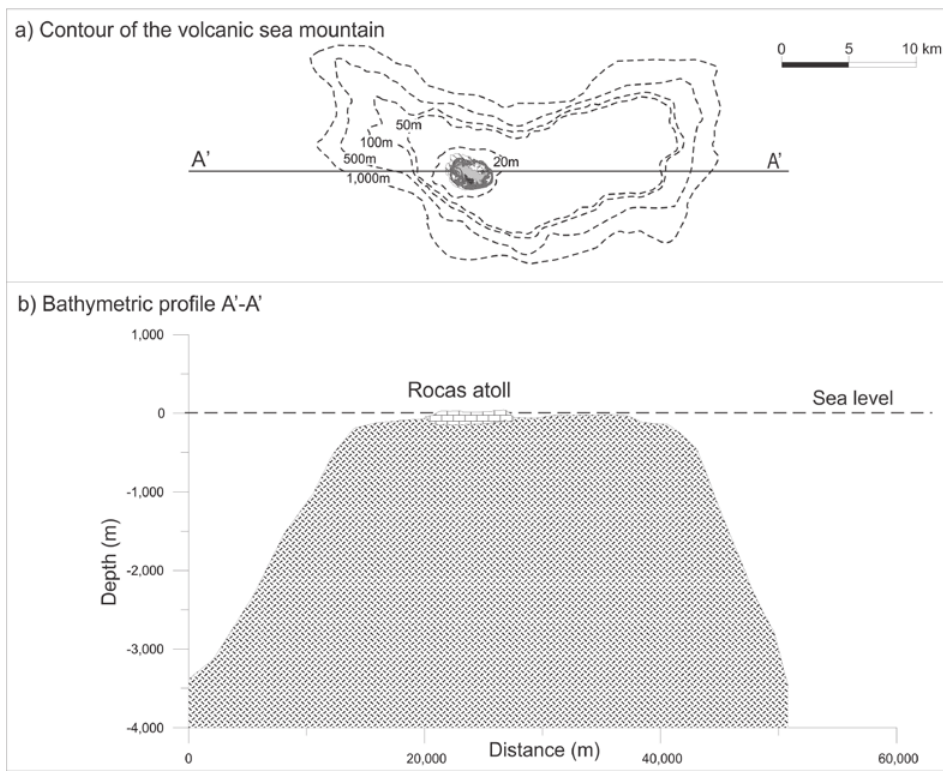
Figure 02 - Schematic illustration of the contour (a) and bathymetric profiles (b) of the Guyot that supports Rocas